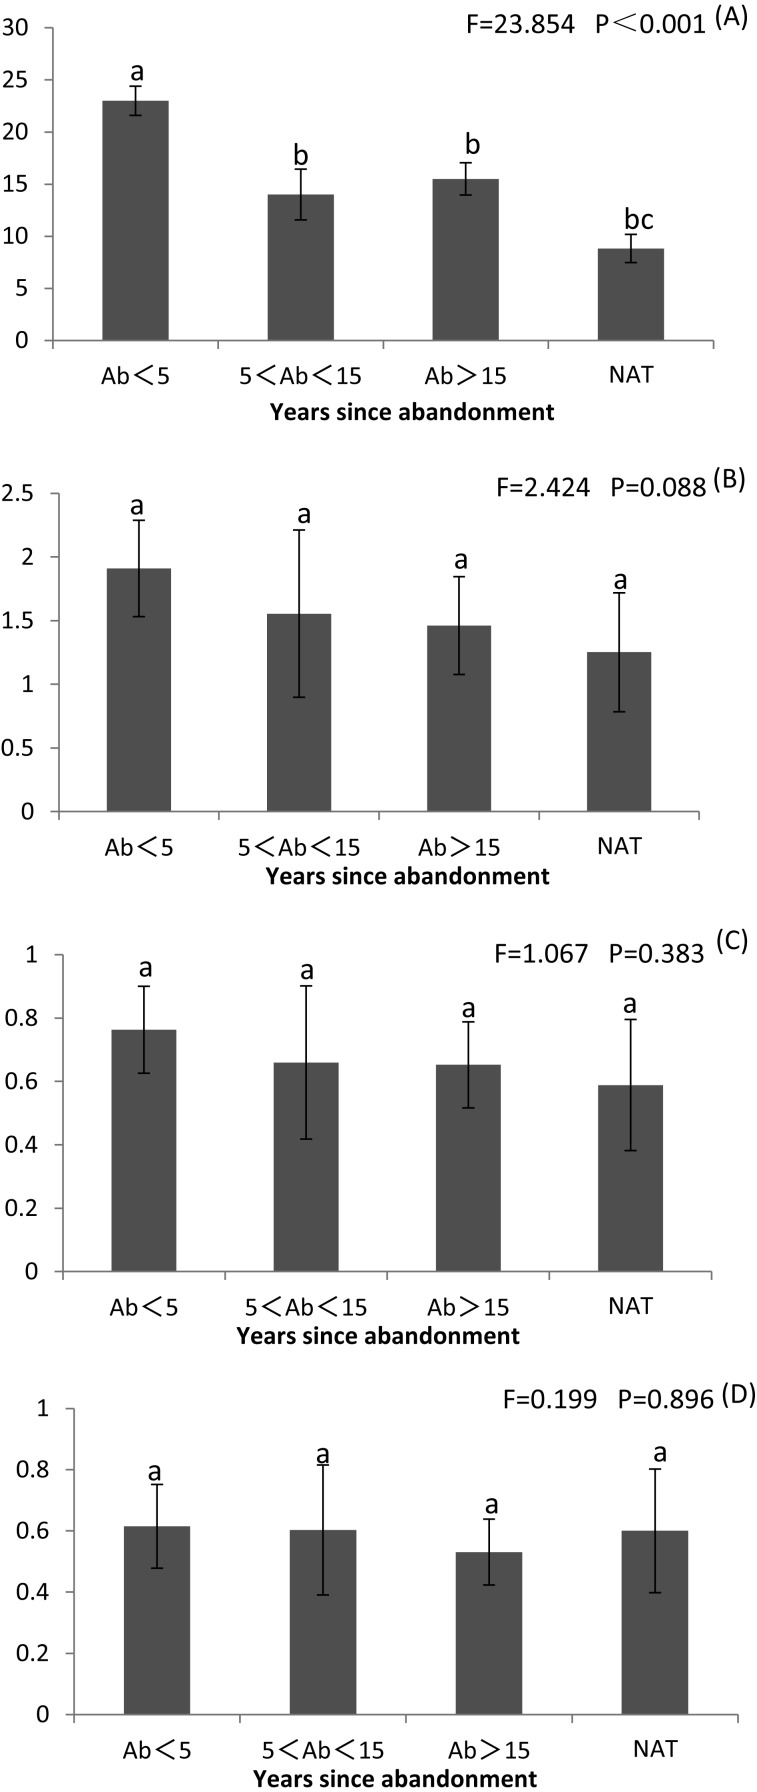
Richness index (R), Shannon–Wiener diversity index (H), Simpson’s index (D) and Pilou’s evenness index (J) of plant communities in paddy fields at different times since abandonment and in natural wetlands.The vertical bar is SD and the letters represent significant differences from post hoc Tukey tests (P < 0.05). (A) Richness index R; (B) Shannon–Wiener diversity index H; (C) Simpson’s index D; (D) Pilou’s evenness index J.